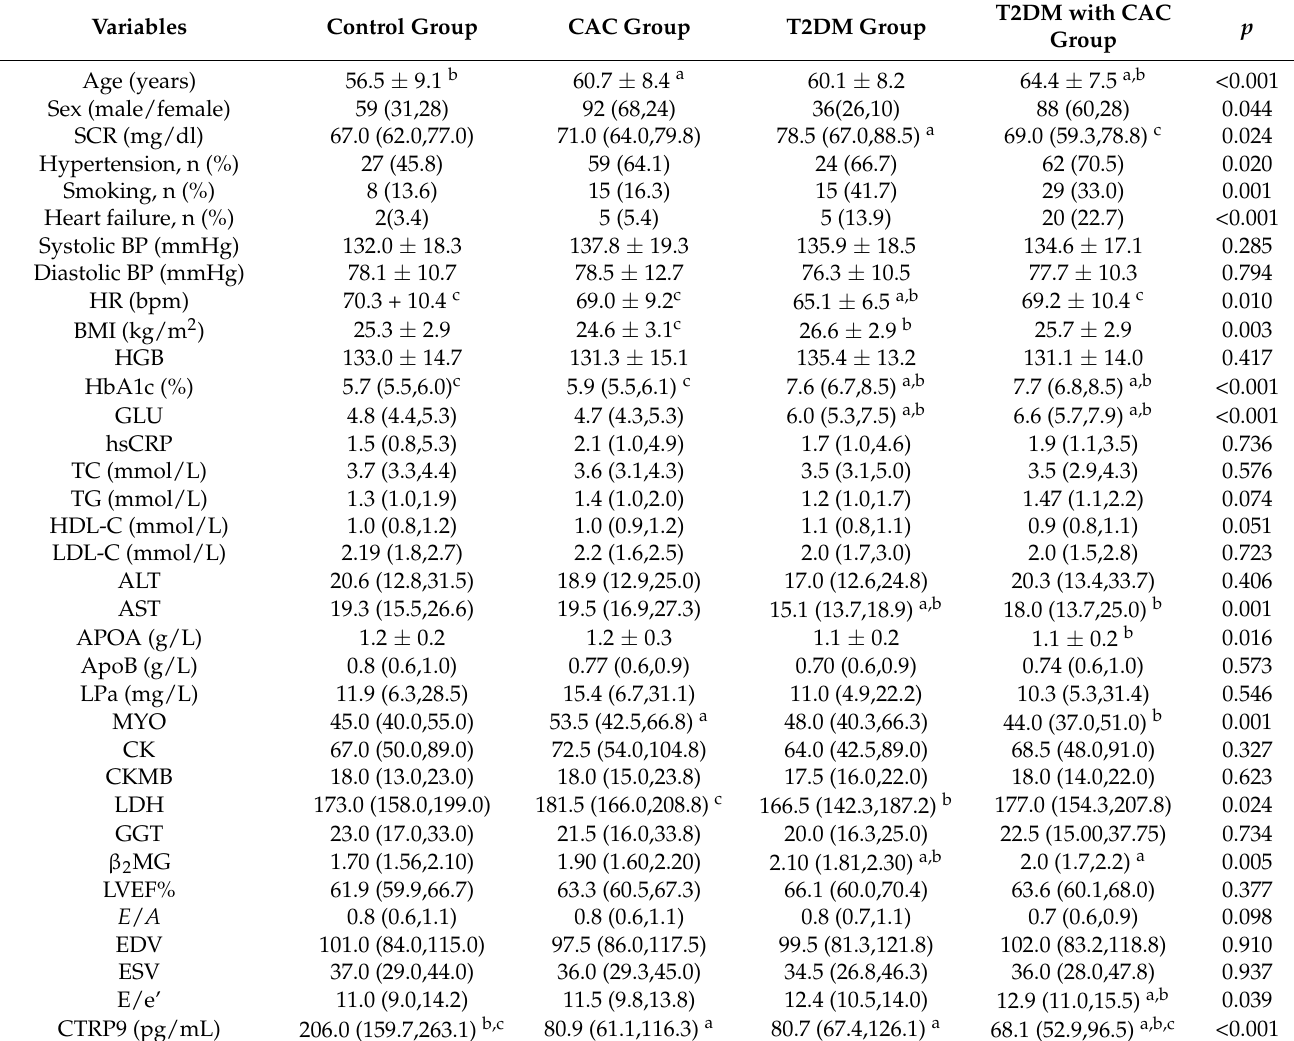
Table 1. Baseline characteristics and general clinical data of each